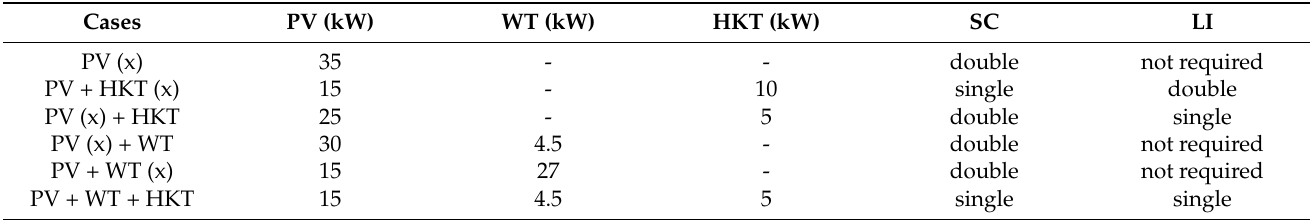
Table 9. Result of the sensitivity analysis regarding the capacity of renewable sources